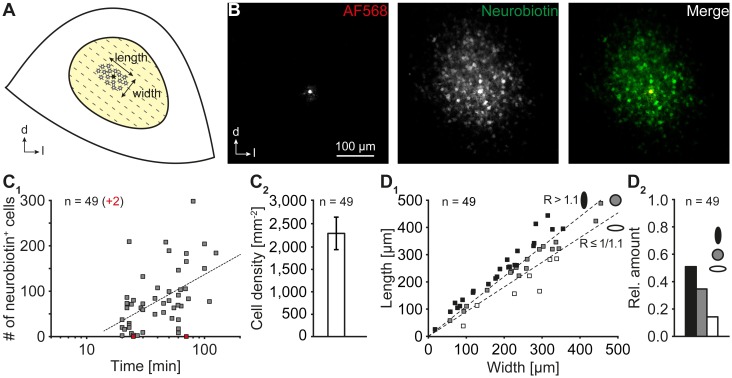
Astrocyte coupling. (A) Scheme depicting the central part of the inferior colliculus. The orientation of “length” and “width” is indicated. A schematic network is represented by asterisks. The patch-clamped cell is marked with a filled asterisk. The tonotopic organization is indicated by dotted lines. (B) The tracer neurobiotin diffused from a patch-clamped astrocyte (AF568) to neighboring cells. (C) Properties of IC networks. The network size depended on the duration of patch-clamping and concomitant injection of neurobiotin into an astrocyte (C1). The increase of network size was slowed during prolonged tracer filling. Note: In two experiments, astrocytes lacked any coupling (red squares). The dotted line represents a logarithmic fit (R2 = 0.2342). IC networks exhibited a high cell density (C2). The vast majority of networks had a non-spheroidal extension (D1) exhibiting an oval shape oriented orthogonally to the tonotopic axis (D2). In (D1) one coordinate pair is located outside the dimensions of the diagram (width/length: 553/565). Length: orthogonal to tonotopic axis. Width: longitudinal to tonotopic axis [see (A)]. n represents the number of experiments and is provided within the diagrams. Shown are mean values ± SEM.